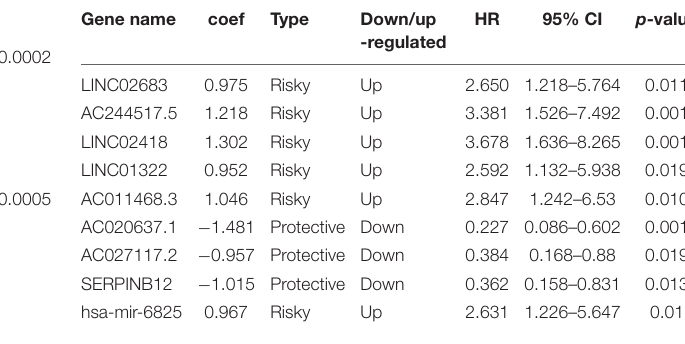
TABLE 2 | Nine genes significantly related to the RFS of stage I-IIIA